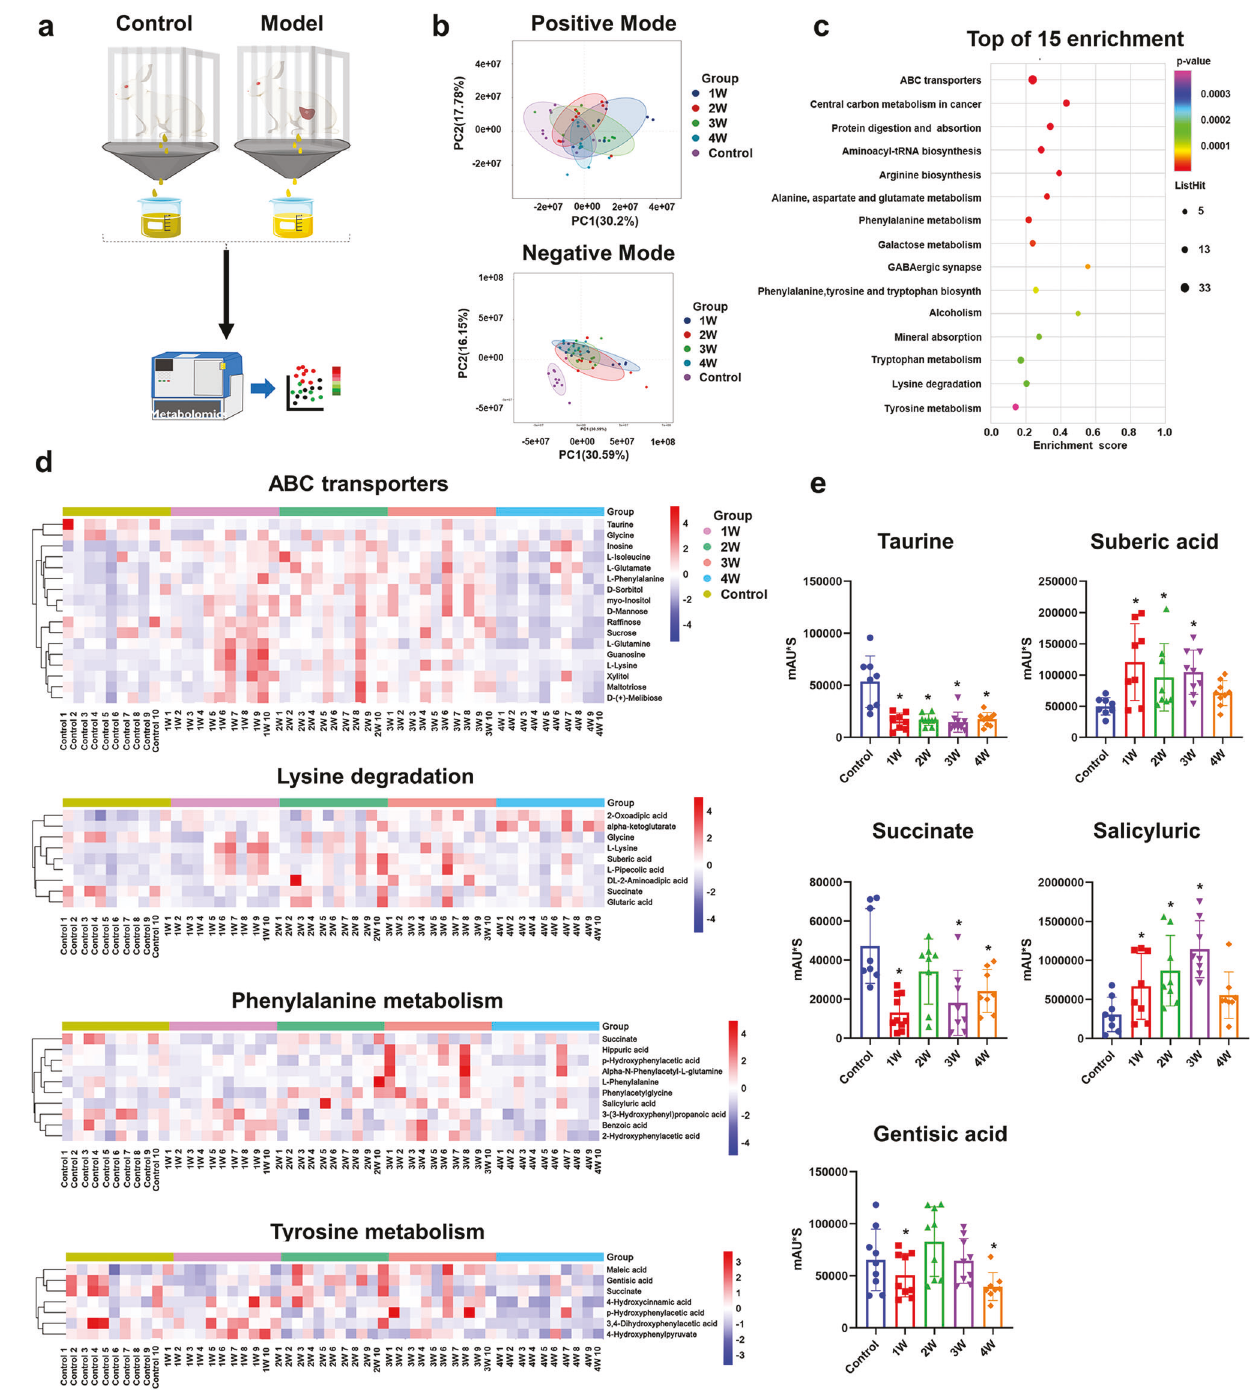
Fig. 2 Metabolomics pro fi ling has identi fi ed fi ve organic molecules as the candidate for crystal inhibitors. a Schematic representing the design of metabolomics pro fi ling experiments. b Principal coordinate analysis (PCoA) for the positive and negative ions of the control and model animal based on metabolite pro fi les of the urine samples. c KEGG pathway enrichment analysis of the control and model groups. d Heatmap of ABC transporters, lysine degradation, phenylalanine metabolism and tyrosine metabolism pathway. e Alteration of the fi ve organic molecules based on metabolite pro fi les and statistical analysis, * P < 0.05 compared with control group. For ( a – e ), n = 10 rabbits in each